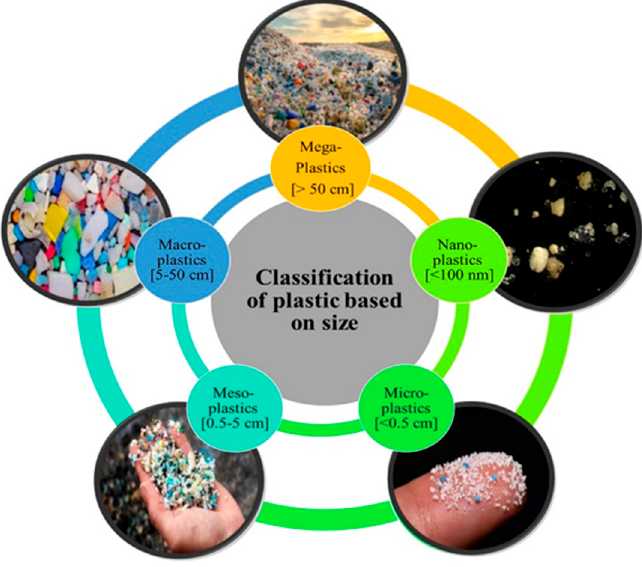
Figure 1. Classification of plastic based on size.